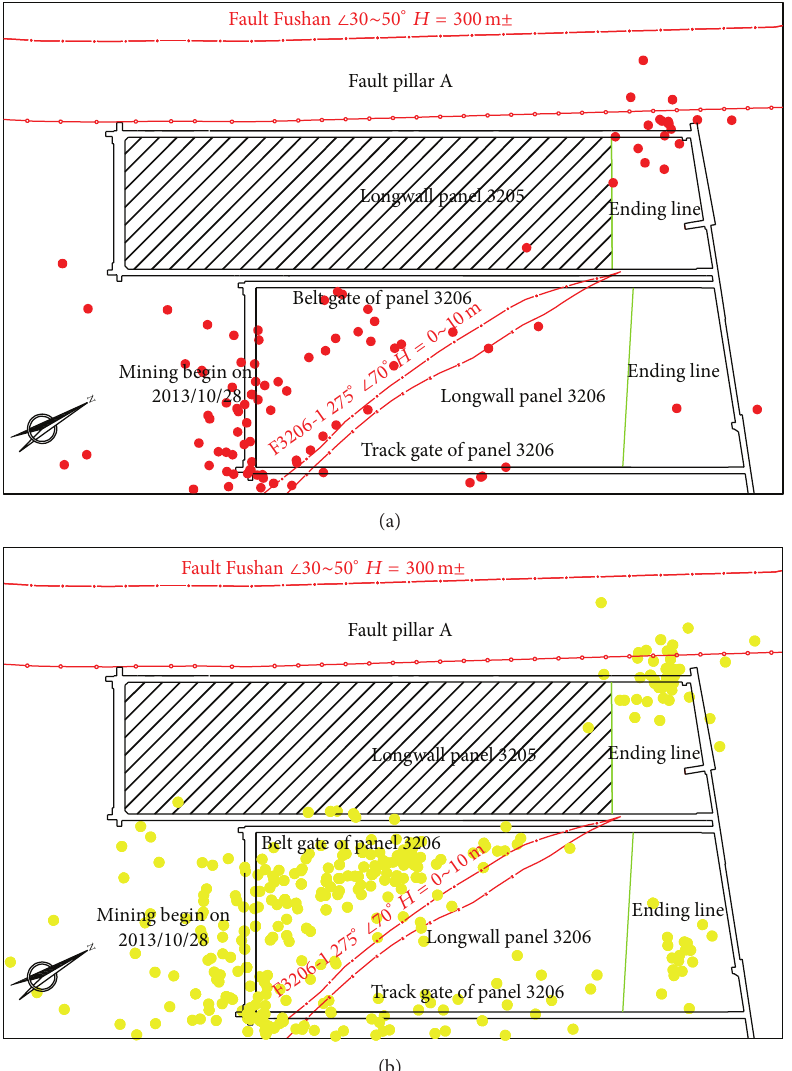
Figure 14: Seismicactivity recorded during longwall drivage-localization map of recorded seismicevents from February 2, 2013, to September 16, 2013. (a) 1000 to 10000 J; (b) >